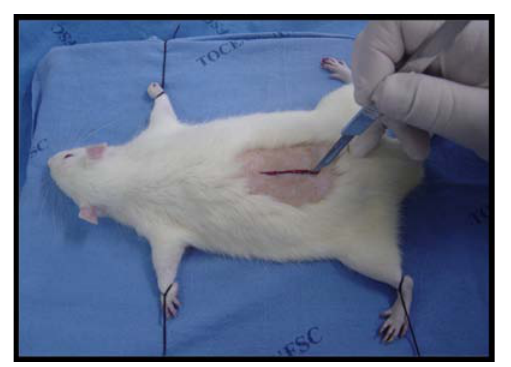
FIGURE 1 - Picture showing 3 cm-incision on animal’s